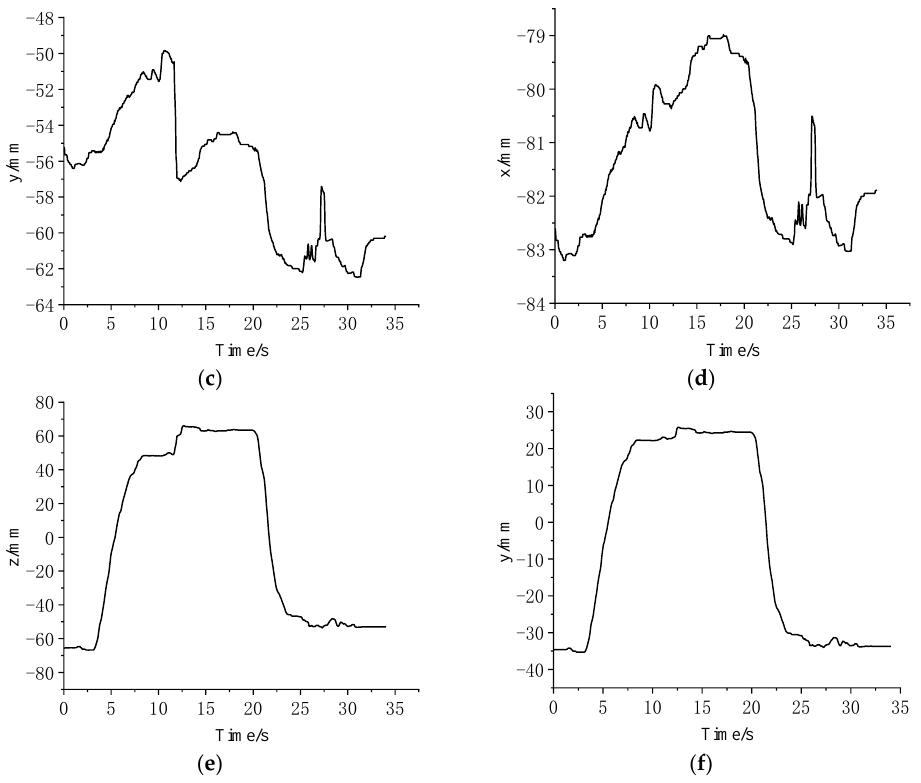
Figure 13. Trajectories of master and slave in the xyz directions. ( a ) Master x direction. ( b ) Slave z direction. ( c ) Master y direction. ( d ) Slave x direction. ( e ) Master z direction. ( f ) Slave y direction.